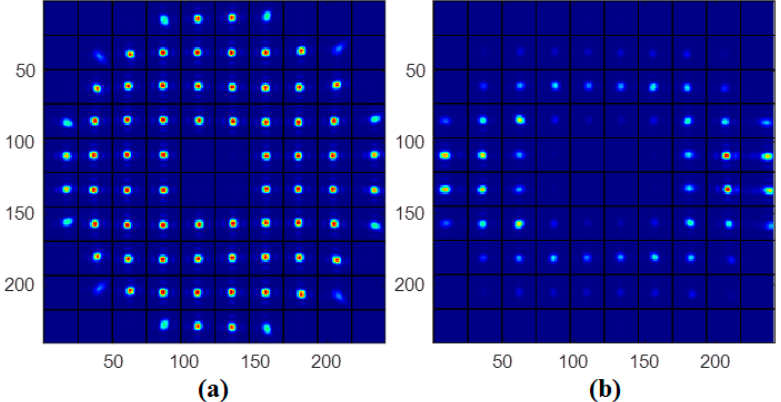
Figure 2. ( a ) The standard sub-aperture image of WFS. ( b ) The sub-aperture image of WFS with non-uniform near-field and irregular spots.